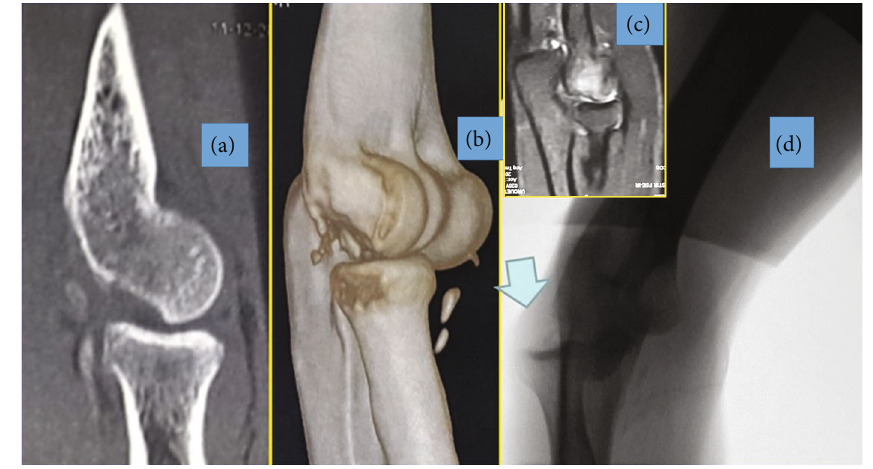
Figure 1: (a, b, and c) TC scan and MRI showing capitellum fracture. (d) Engaging pivot